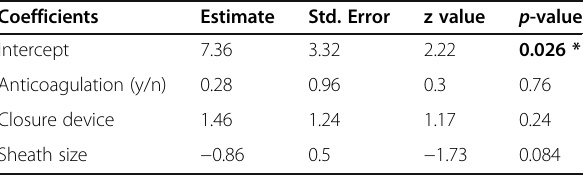
Table 5 General linear model with anticoagulation (y/n), closure device (y/n) and sheath size (French, numeric) as predictors for which separate